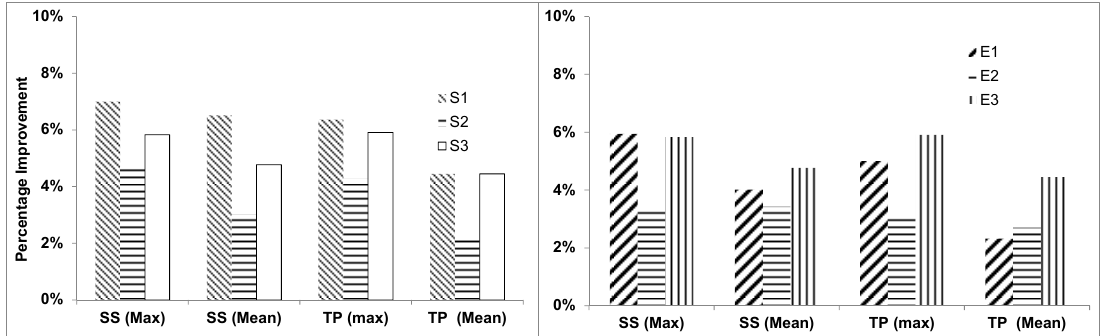
Figure 9. Plots showing the percentage reductions in TP and SS concentrations modelled at the NBC outlet achieved under: LH pane shows the three scenarios (legend indicates the scenario number) relative to the baseline in Event 3 only, and the RH pane shows the improvements under Scenario 3 relative to the baseline only, with Events 1 – 3 shown for comparison (improvements in Events 1–3 shown with different fill patterns).